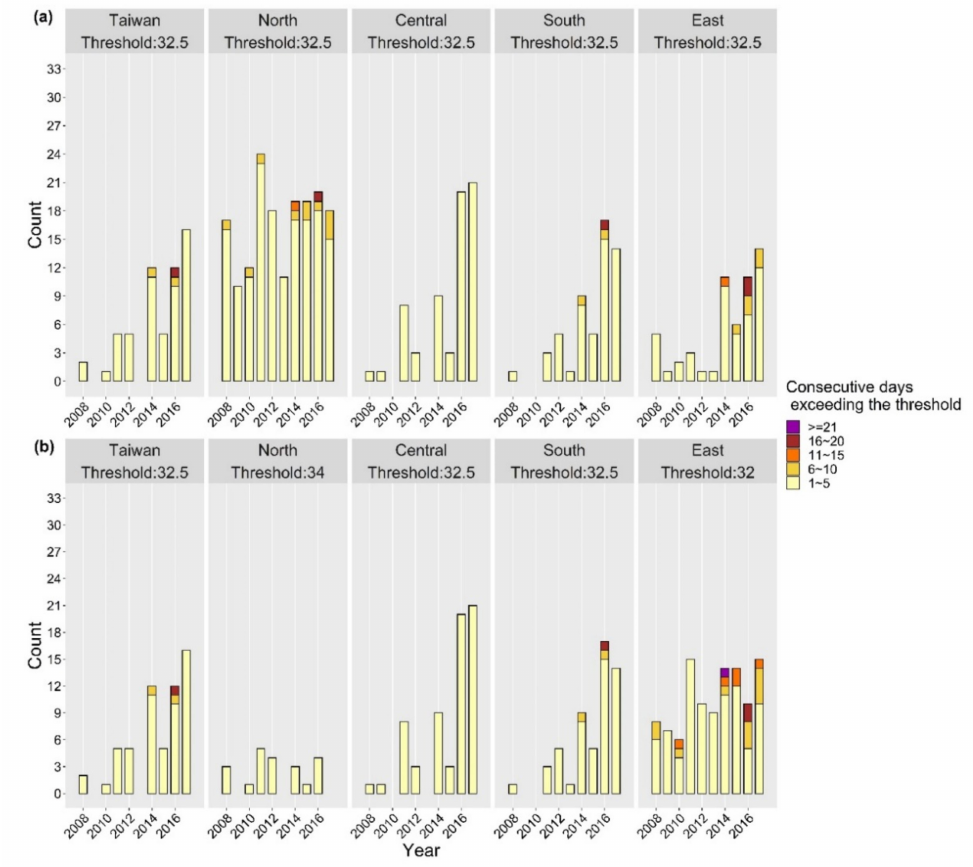
Figure 4. Counts of periods of consecutive days exceeding the specified WBGT thresholds in different sub-regions of Taiwan between 2008 and 2017; ( a ) the same threshold for all sub-regions and ( b ) region-specific